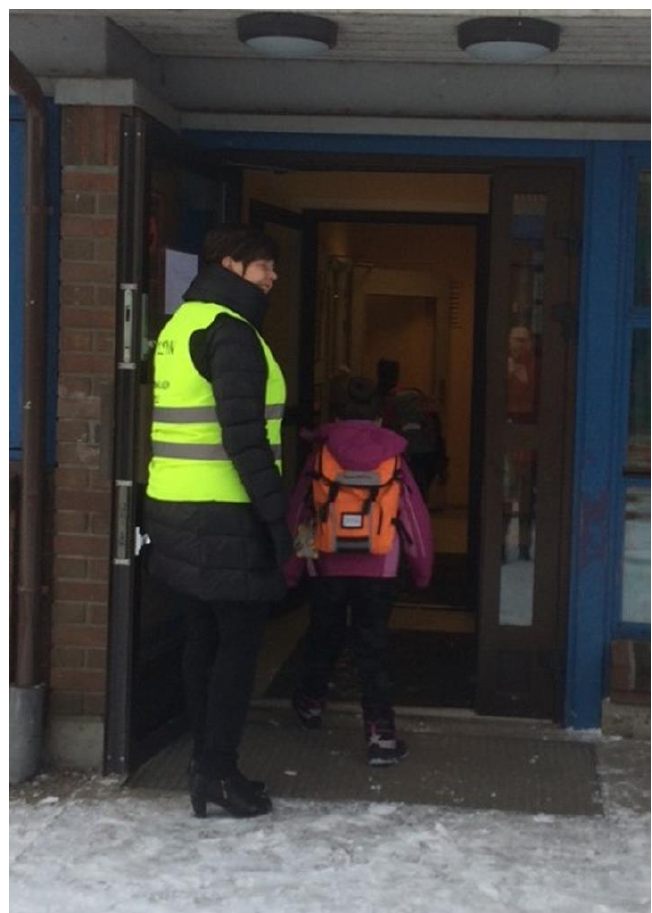
Figure 4. Principal greeting pupils every morning (photograph taken by Parent 2).